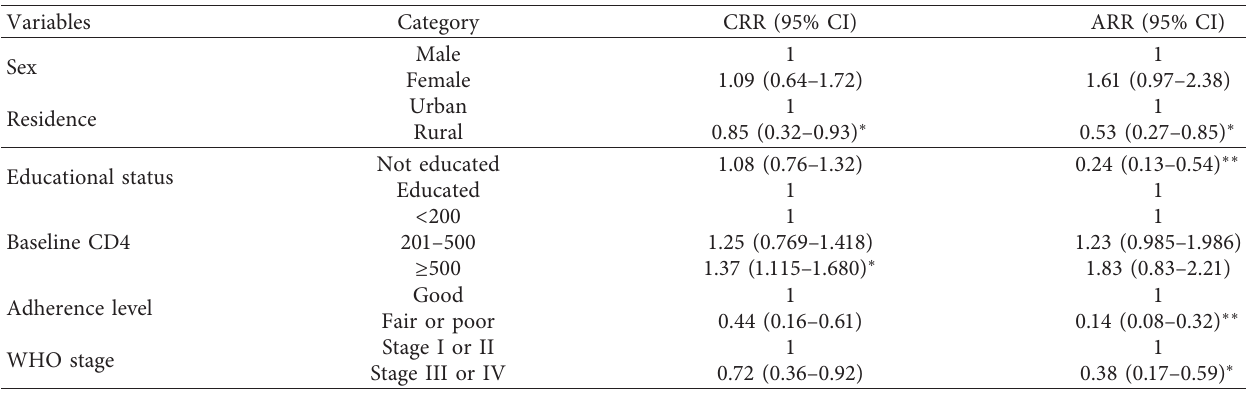
Table 3: Multivariate analysis for the predictor of recovery from malnutrition, Finote-Selam Hospital, Northwest Ethiopia, 2010–2017.